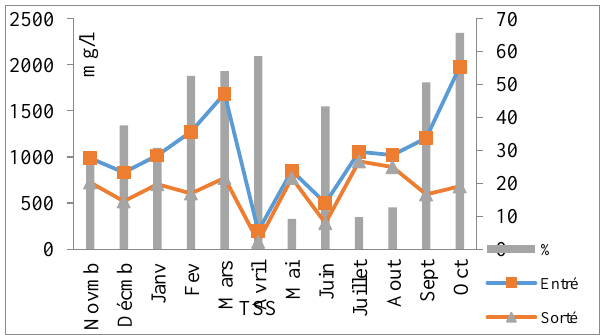
Figure 8. Variation of TSS values at the entrance and exit of the WWTP